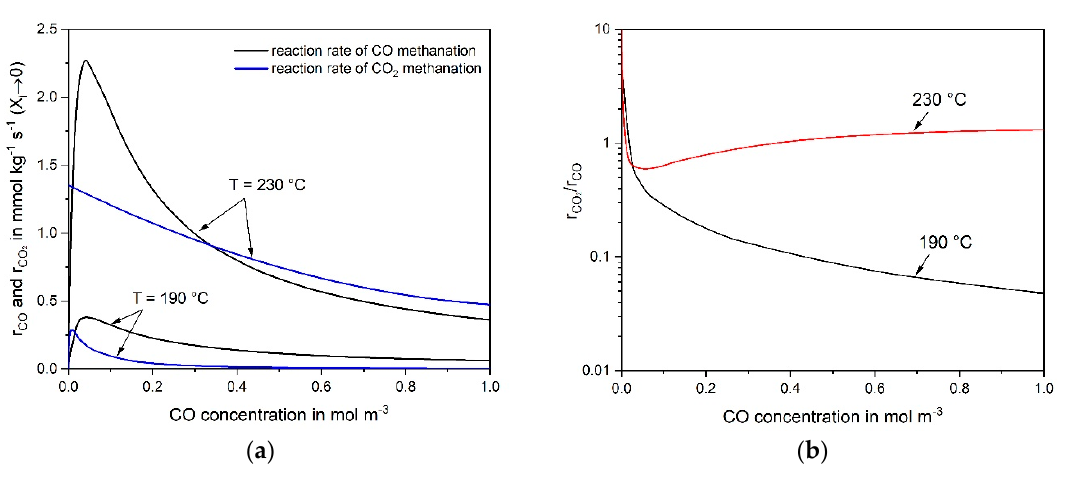
Figure 4. ( a ) Calculated initial CO and CO 2 reaction rates (Equations (4) and (6)) and ( b ) ratios for different CO concentrations (20% CO 2 , 55% H 2 in N 2 , m cat = 2 g, 𝜏 (190°C) = 413 kg·s·m − 3 , 𝜏 (230°C) = 380 kg·s·m − 3 , 1 bar).